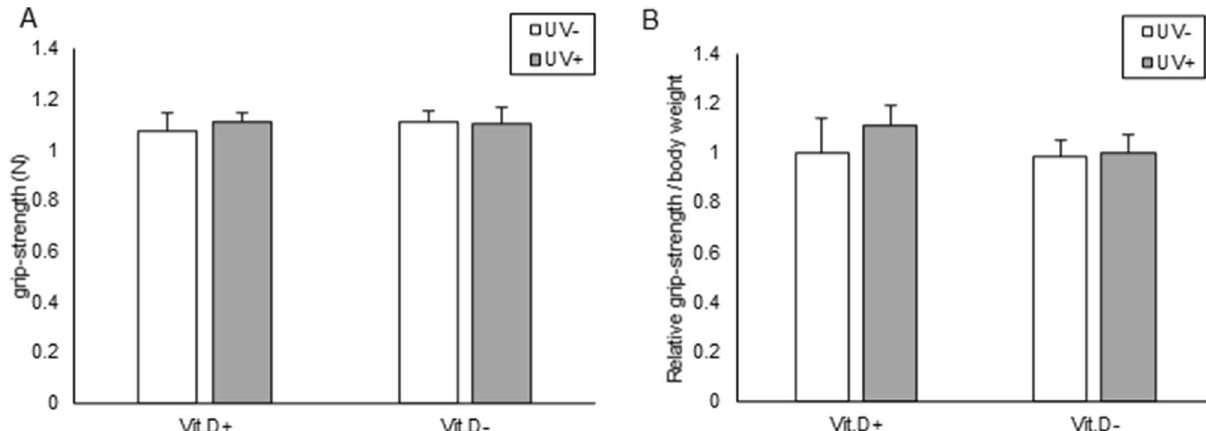
Figure 12. Muscle strength analyses. ( A ) Grip strength at 48 weeks of age was determined with reference to that in Vit.D+ UV− group as 1.0. measured in 15 trials per mouse. ( B ) Grip strength normalized with body weight. Vit.D − vitamin D-deficient diet; Vit.D + vitamin D-replete diet; UV ultraviolet